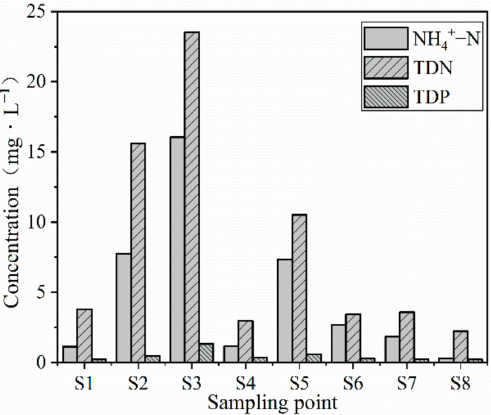
Figure 3. Nutrient concentration of interstitial water at each sampling point of the Yitong River. The average concentration of TDN was 8.2 mg · L − 1 , and the variation range of con- centration was 2.2–23.5 mg · L − 1 . The variation trend was the same as NH 4+ -N, and the maximum value still appeared at point S3. Except for S2 and S6 sampling points, there was a slight difference in TDN concentration between overlying water and interstitial